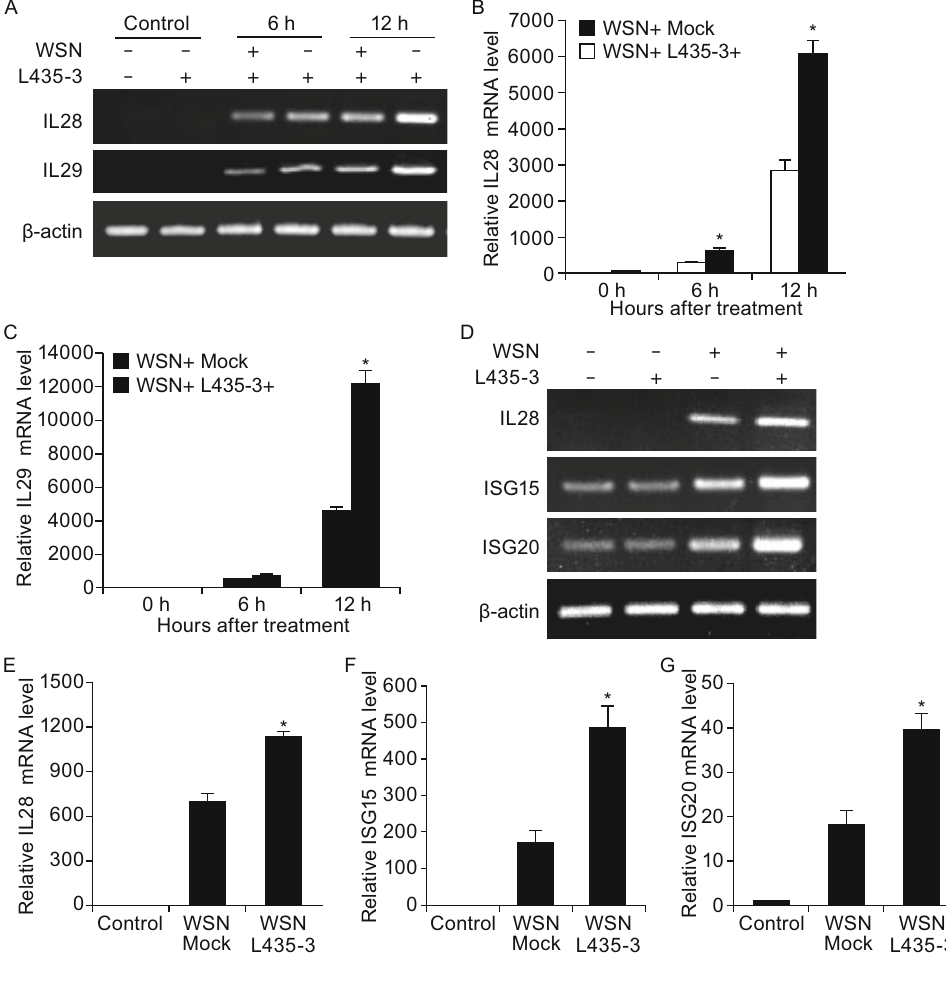
Figure 2. L435-3 treatment increases the expression of type III interferons and ISGs both in A549 cells and in mice infected with IAV . (A) WSN-infected A549 cells were treated with or without L435-3 (0.5 μ mol/L) for 6 h and 12 h, and then the mRNA levels of indicated genes were analyzed by RT-PCR. (B and C) WSN-infected A549 cells were treated with or without L435-3 as described in (A). The mRNA levels of IL28 (B) and IL29 (C) were analyzed by quantitative real-time PCR. (D) WSN-infected BALB/c mice were treated with or without L435-3 (0.3 mg/kg/mouse) for 3 days. Then the mice were sacri fi ced, and the mRNA levels of indicated genes in mouse lung were detected by RT-PCR. (E, F and G) WSN-infected BALB/c mice were treated as described in (D). The mRNA levels of IL28 (E), ISG15 (F) and ISG20 (G) in mouse lungs were detected by quantitative real-time PCR. * P